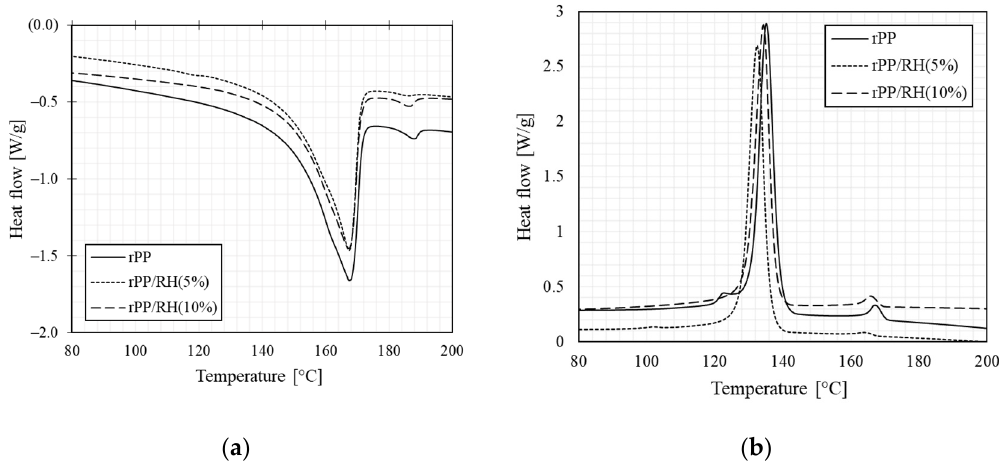
Figure 5. ( a ) DSC melting and ( b ) crystallization thermograms of rPP and rPP/RH composites.